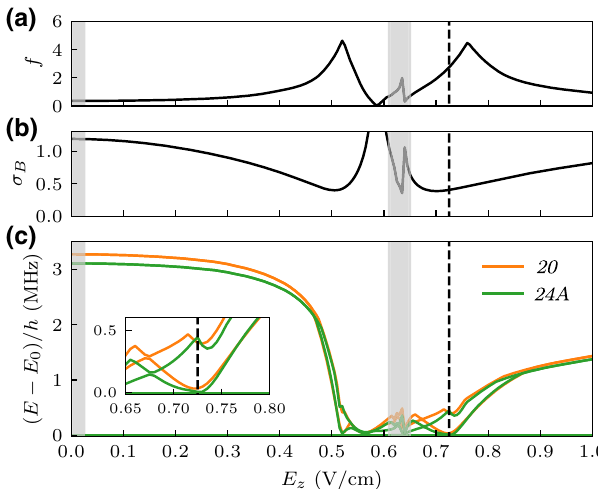
FIG. 7. The optimization of the electric field. (a) The flatness ratio f of the lowest band of the single-particle band structure as a function of the electric field E z (the gray regions indicate regimes where our perturbative calculation of hopping ampli- tudes fails). A large flatness ratio is beneficial for realizing a fractional Chern insulator in the many-body regime. (b) The Berry-curvature fluctuations σ B . Typically, a small value is desir- able. Note that f and σ B reach their respective optimal values for different E z . Thus, we have to make a compromise. (c) To figure out the optimal value of E z , we calculate the three low- est eigenenergies on a torus at quarter filling for the clusters 20 and 24A . The ground state is nearly twofold degenerate in a small region around the optimal value E z = 0.725 V / cm (dashed lines). The inset shows an enlargement of this region.